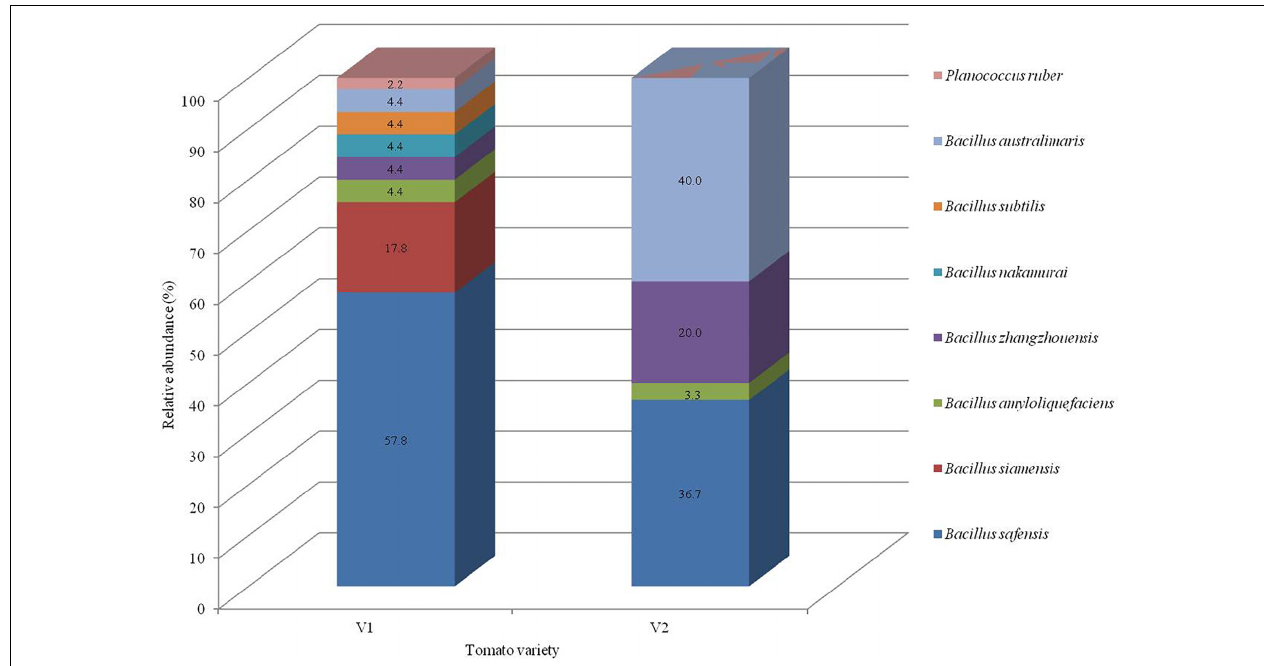
FIGURE 1 | Taxonomic profiles of the bacterial community in each variety at the representative species level with the relative